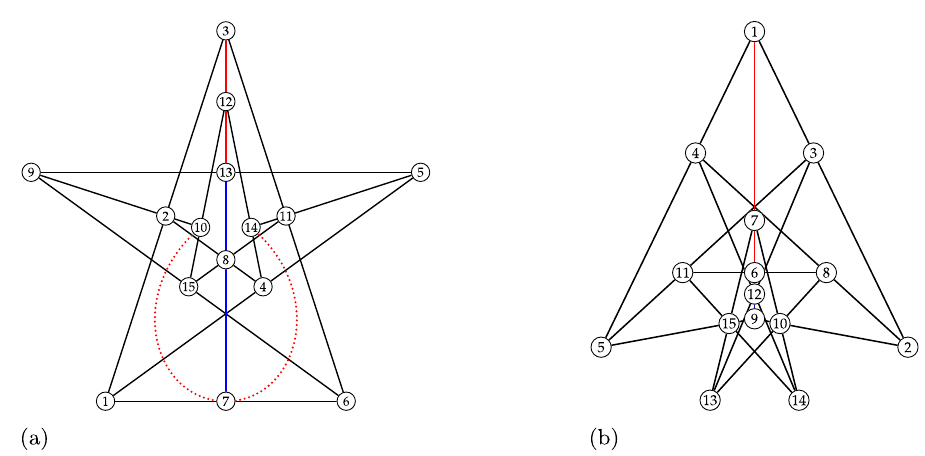
Figure 4: Two con fi gurations of automorphism groups C C 2 2 × ( of order 4 ) and C 2 ( of order 2 ) . ( a ) 15A, ( b ) 15B.